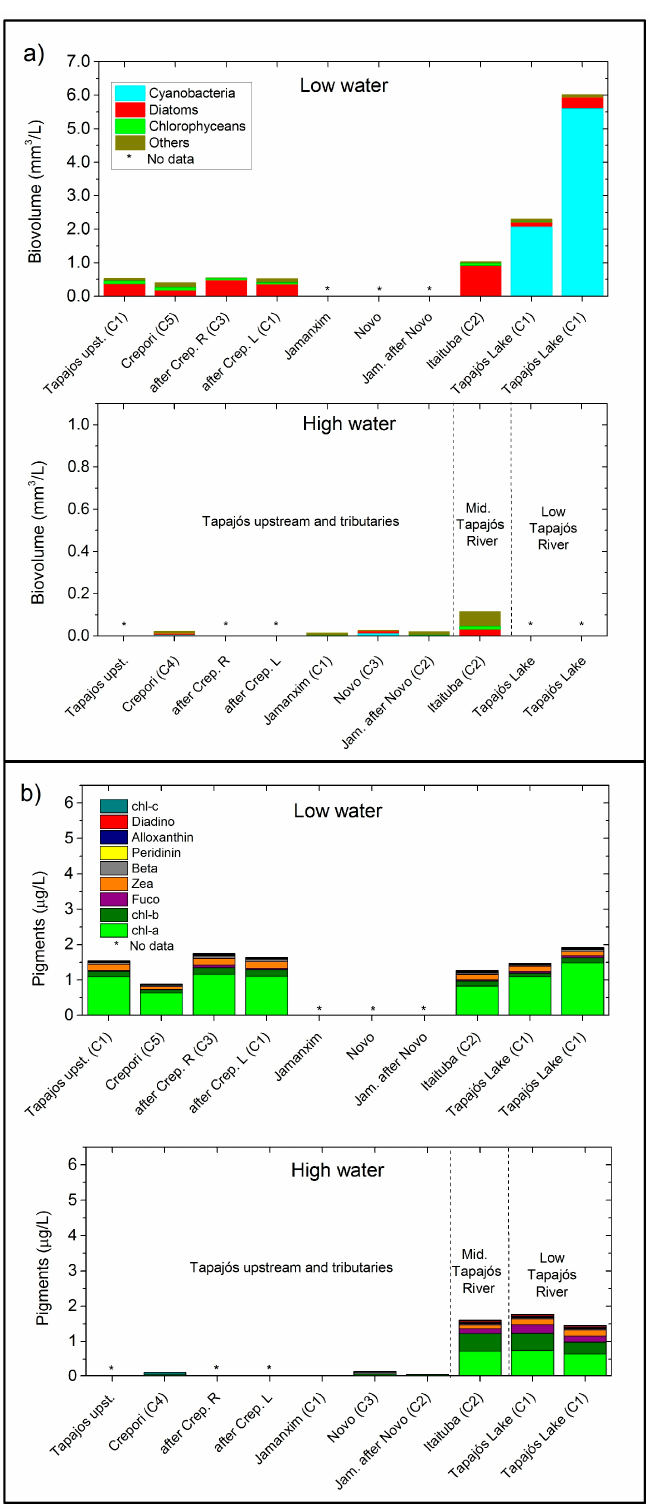
Figure 4. ( a ) Spatial distribution of phytoplankton groups (mm 3 ·L − 1 ) along the Tapajós River for low and high water level periods. ( b ) Spatial distribution of pigments concentration ( μ g·L − 1 ) for the same seasons. The correspondent TSS class is indicated in parentheses for each sample point, except for point stations with no data available, which is indicated by asterisks.